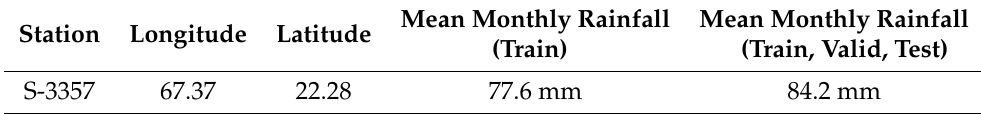
Table 1. S-3357 meteorological station.